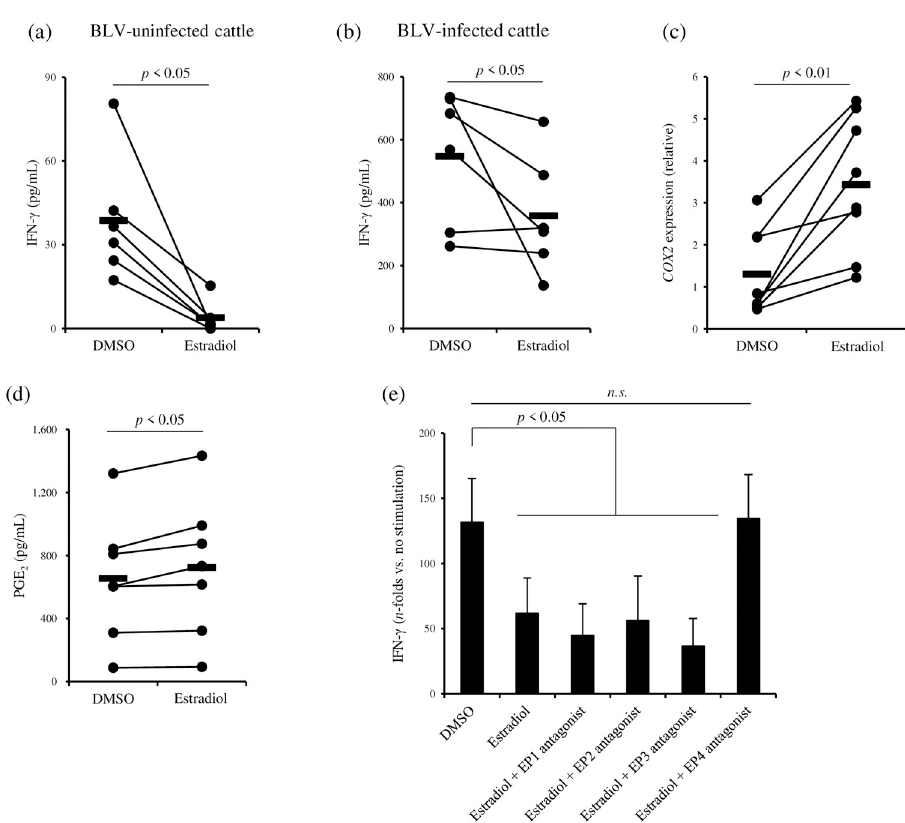
Fig 3. Immunosuppressive function of estradiol via PGE 2 induction. (a and b) PBMCs from BLV-uninfected or BLV-infected cattle were cultured with estradiol in the presence of anti-CD3 mAb and anti-CD28 mAb or FLK-BLV, respectively (a: BLV-uninfected cattle, n = 6, b: BLV-infected cattle, n = 6). DMSO was used as a vehicle control of estradiol. IFN- γ concentrations in culture supernatants were quantitated by ELISA. (c and d) PBMCs from BLV- uninfected cattle were cultivated with estradiol, and COX2 expression (c, n = 8) and PGE 2 concentration (d, n = 7) were measured by real-time PCR and ELISA, respectively. (e) PBMCs from BLV-uninfected cattle ( n = 10) were pretreated with each EP antagonist for one hour, and then cultured with estradiol in the presence of anti-CD3 mAb and anti-CD28 mAb. IFN- γ production in culture supernatant was determined by ELISA. (a–d) Statistical significances were determined by the Wilcoxon signed-rank test. (e) Data are presented as mean ± SD, and statistical significance was determined by the Steel-Dwass test.